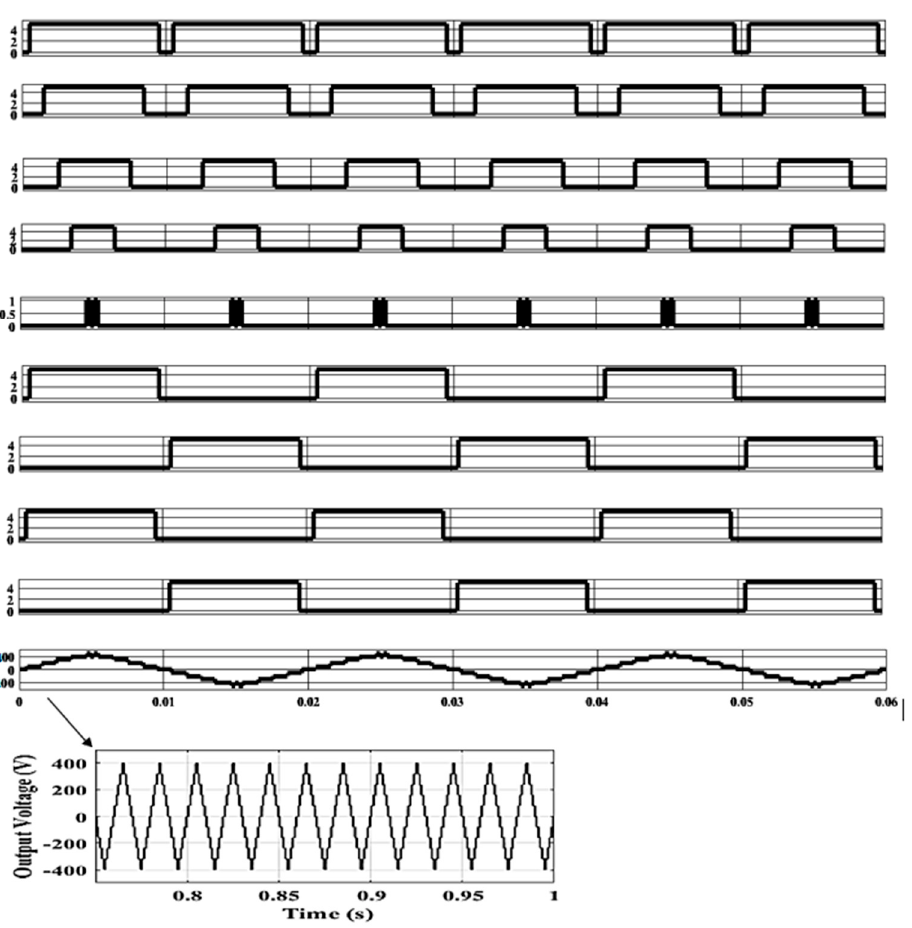
Figure 19. Pulse waveforms and output voltage waveform of the proposed